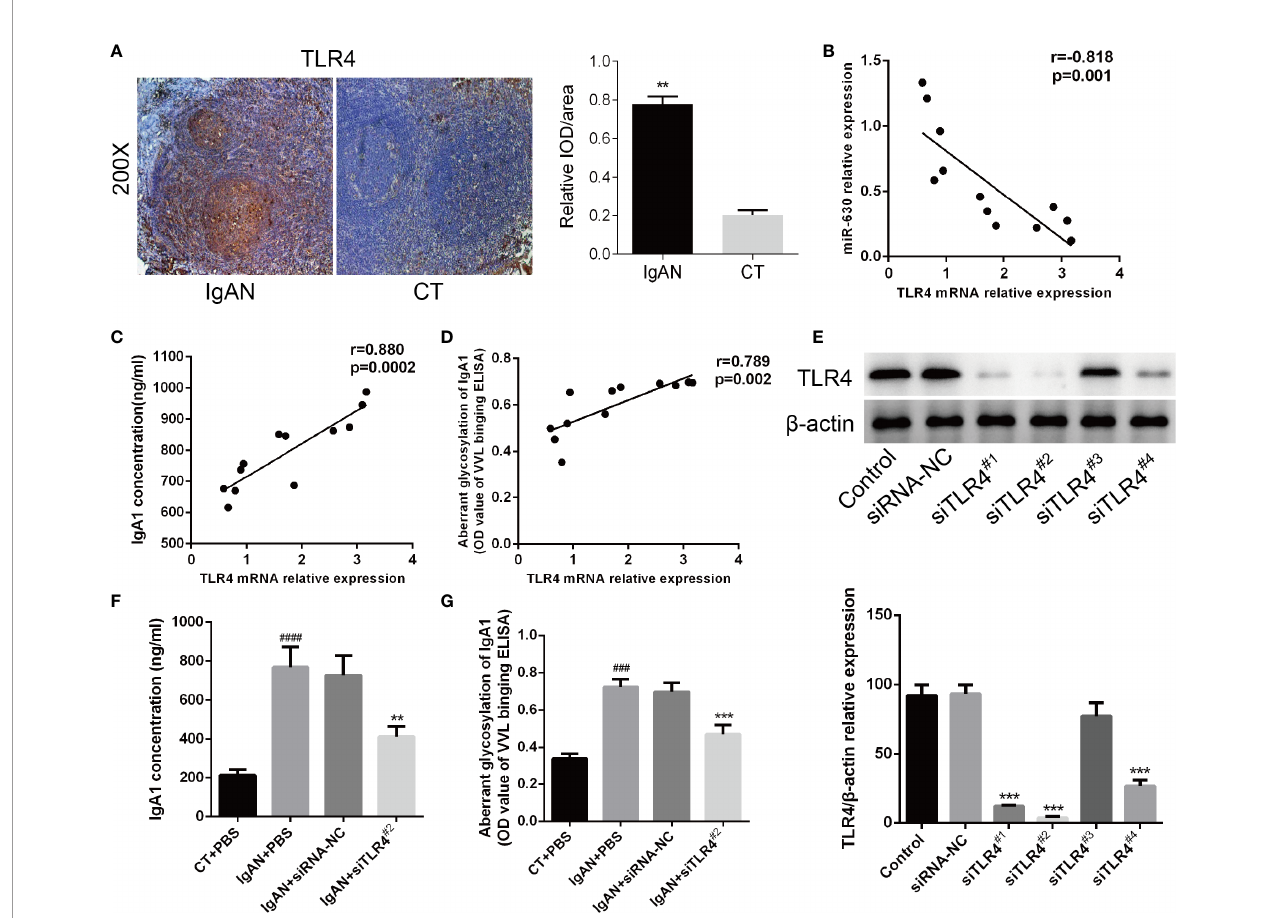
FIGURE 4 | TLR4 is involved in miR-630 regulating the concentration and glycosylation levels of IgA1 in IgAN. (A) Semi-quantitative analysis of immunohistochemistry staining showed the expression of TLR4 in the IgAN group and CT group. Representative images were shown. N=5. (B) The expression of TLR4 mRNA was negatively correlated with miR-630 in the TMCs derived from the IgAN group. (C, D) TLR4 mRNA expression was positively correlated with the concentration of IgA1 and the binding force of IgA1 with the broad bean lectin. (E) The validity of TLR4 small interfering RNAs (siRNAs) was veri fi ed by western blot analysis. (F, G) Knocking down the expression of TLR4 made the concentration of IgA1 and the binding force of IgA1 with the broad bean lectin decreased signi fi cantly in TMCs derived from IgAN. The data were expressed as mean ± SEM, **p < 0.01.***p < 0.001, compared with siRNA-NC; ### p < 0.001, #### p < 0.0005, compared with CT. IgAN, IgA nephropathy; CT, chronic tonsillitis; NC, negative